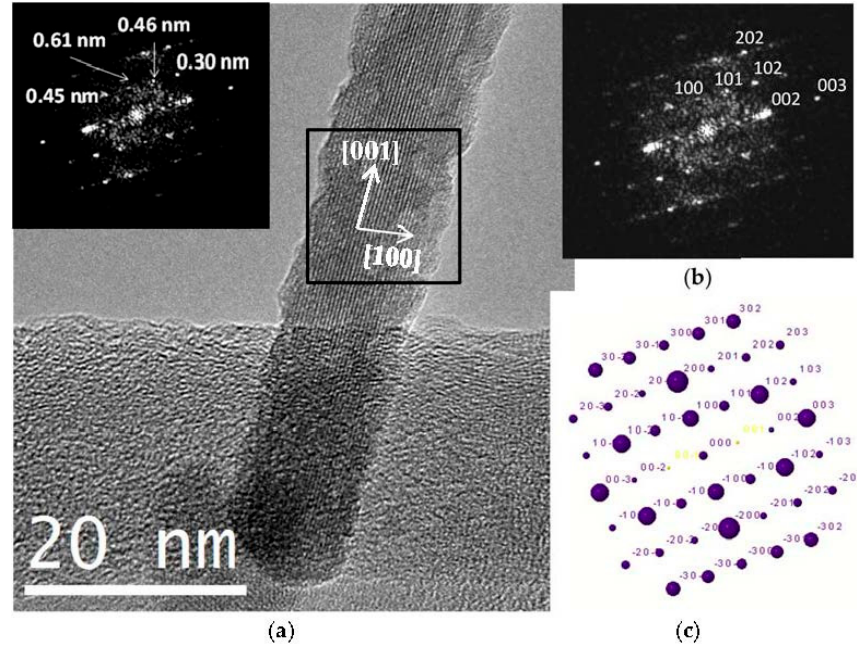
Figure 6. ( a ) HRTEM image of a representative nanofiber of as-prepared C12GA-templated nanofibrous CePO 4 (60 °C-dried and washed xerogel), the inset showing the corresponding digital diffraction pattern (DDP) of the region marked with an square, with indicated distances; ( b ) same DDP with indexed ( hkl ) values (taken along zone axis [uvw]: [010]); ( c ) Corresponding simulated kinetic diffraction diagram.